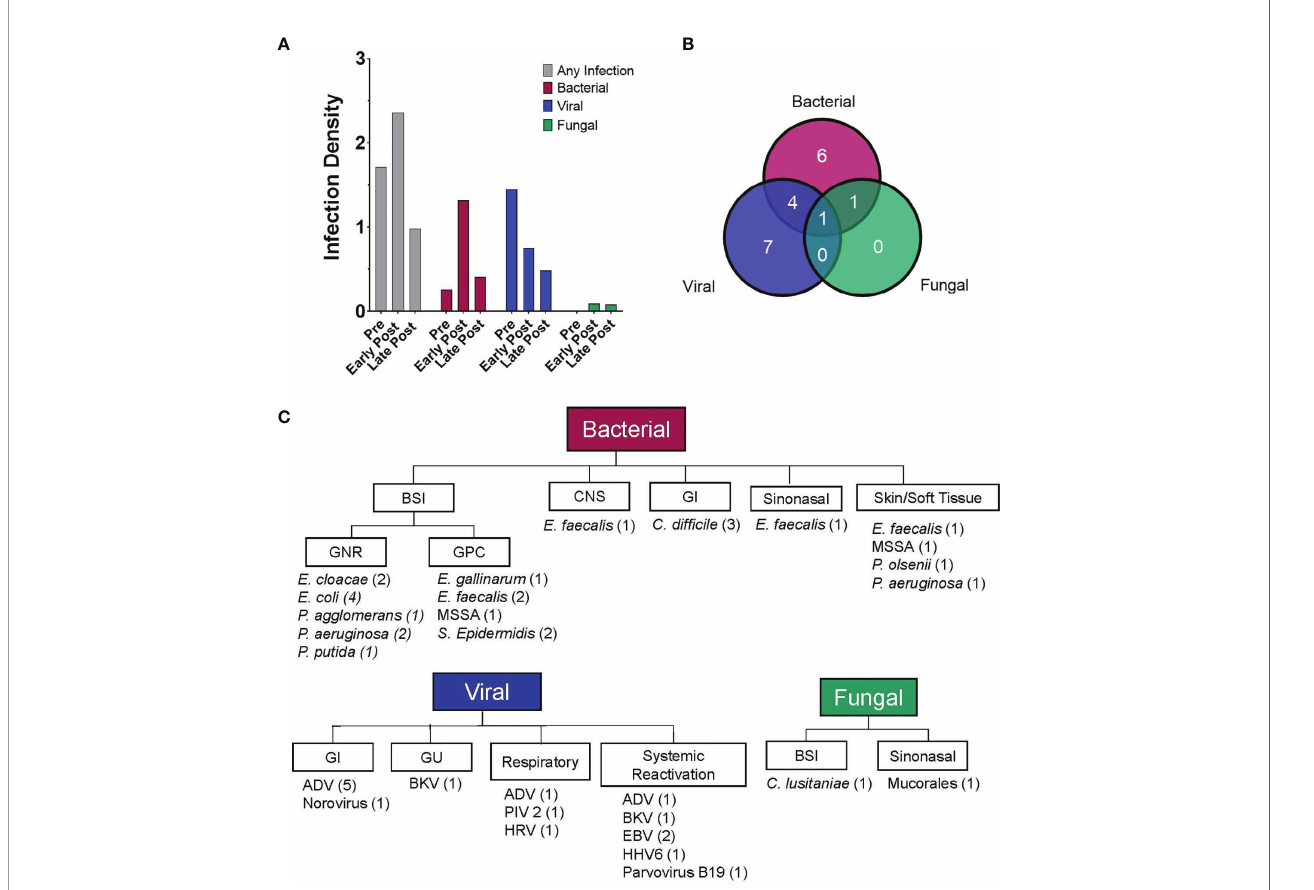
FIGURE 2 | Patients experienced a high rate of infections post CD19-CAR T cell therapy. (A) Bar graphs depicting the infection density per 100 days-at-risk, for any infection and by pathogen category (bacterial, viral and fungal). Data is displayed for three time periods, pre-CAR T cells (day -30 to day 0), early post CAR T cells (day 1 to day 28) and late post CAR T cells (day 29 to day 90). Infections occurred in 30.8% (infection density, 1.709), 34.2% (infection density, 2.358), and 24.2% (infection density, 0.978) of infusions, in the pre-, early post and late post CAR T cell therapy periods, respectively. (B) Venn diagram showing the number of patients experiencing at least one infection over the entire study period (n = 19) and depicting the types of infection experienced by each patient (bacterial, viral and/or fungal). (C) Flow diagram displaying details of infections experienced by pediatric and AYA patients after CD19-CAR T cell therapy (day 0 to day 90 post infusion). The fi gure depicts infection category, sites of infection, infectious pathogens (number of patients identi fi ed with that pathogen), for all patients after CD19-CAR T cell